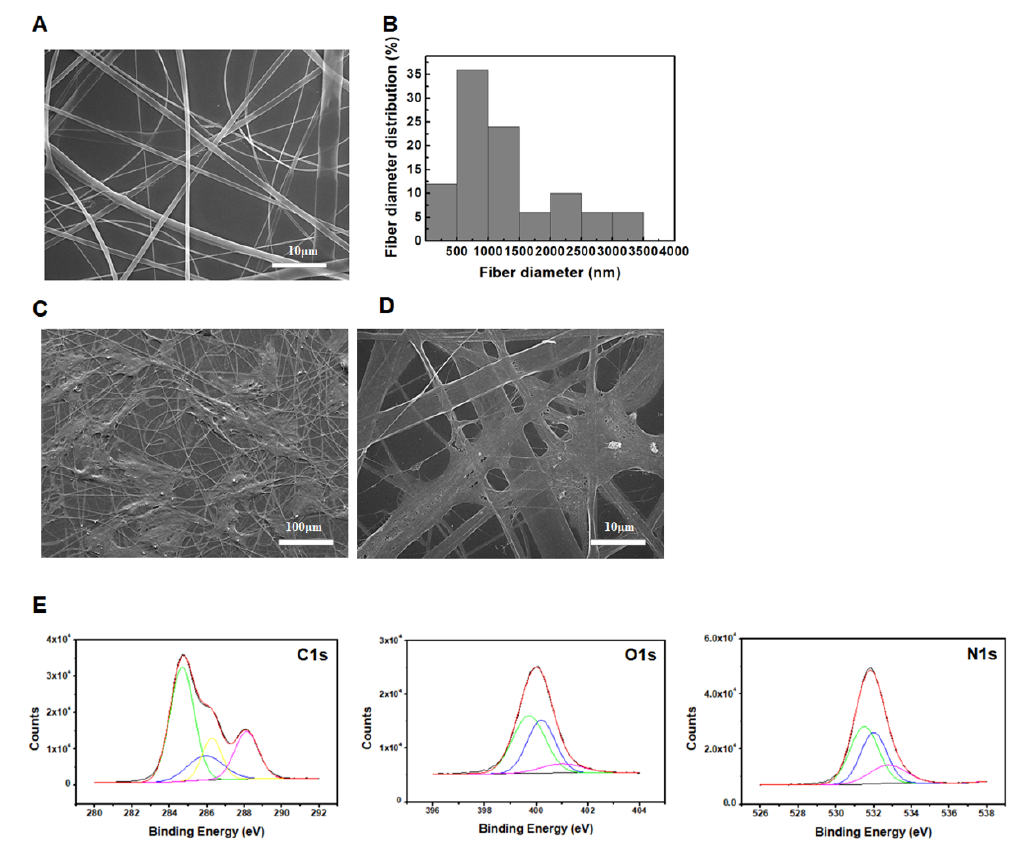
Figure 1. Properties and characterization of the electrospun SF nanofibers. ( A ) Scanning electron microscope (SEM) images of the SF nanofibers. Scale bar = 10 µ m. ( B ) Histograms depicting the diameter distribution of the SF nanofibers. ( C , D ) Human bone marrow-derived MSCs on the SF nanofibers fixed in 2% glutaraldehyde, and ultrastructural images obtained by SEM. Scale bar = 100 µ m, 10 µ m. ( E ) X-ray photoelectron spectroscopy (XPS) analysis of the electrospun SF